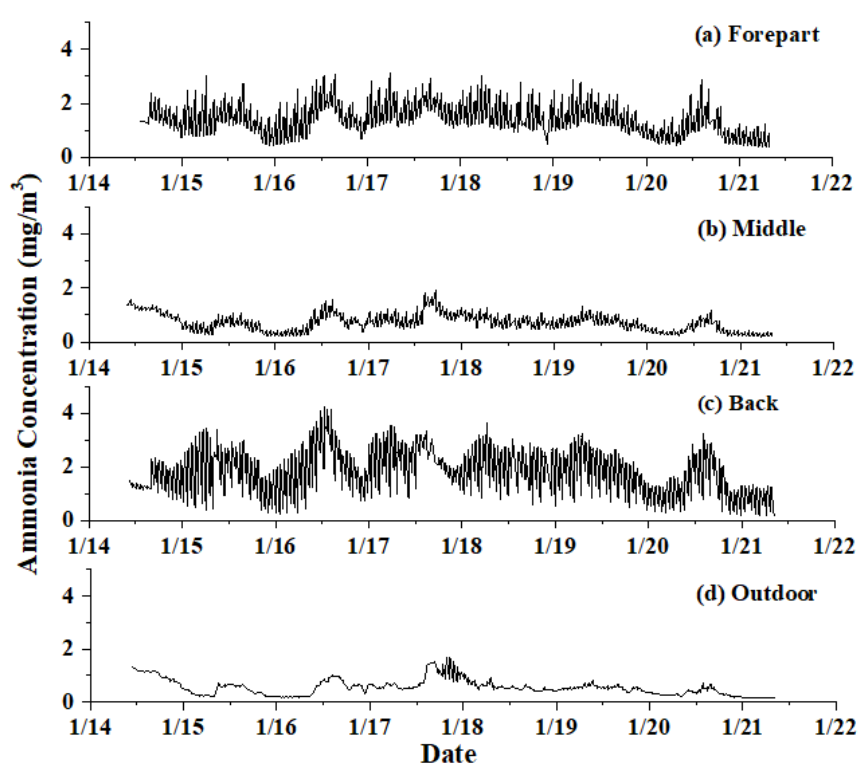
Figure 5. Variation of ammonia concentration in the pig house in winter. ( a ) Forepart; ( b ) Middle; ( c ) Back; ( d ) Outdoor.